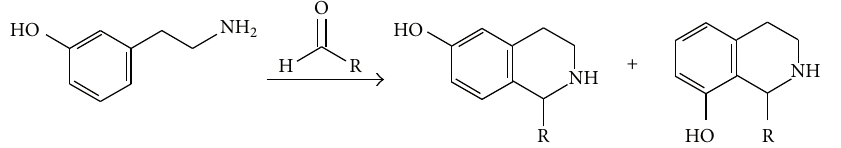
S 1: Pictet-Spengler